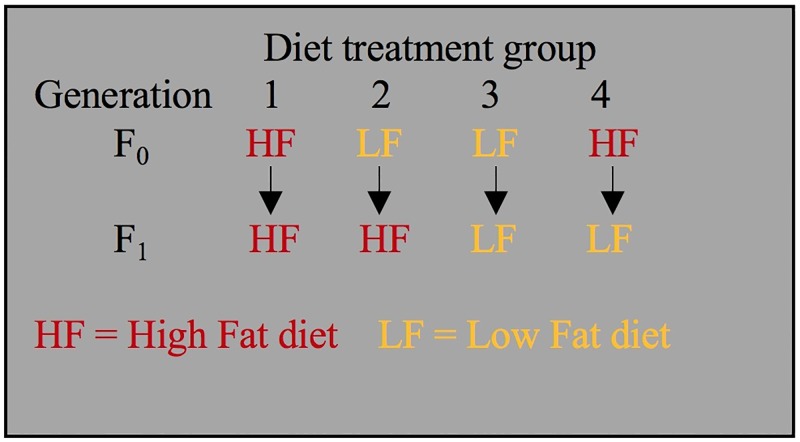
Experimental design.